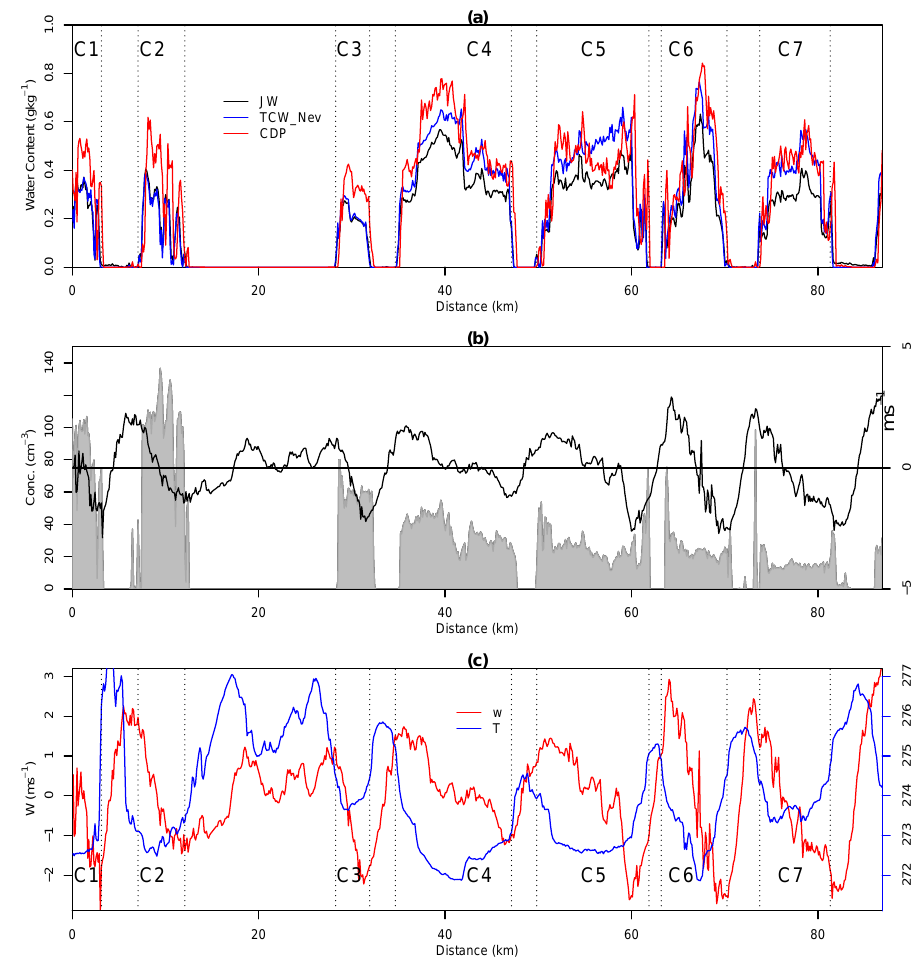
Fig. 4. (a) The LWC measured by the Johnson-Williams probe, the Nevzorov total cloud water, and as derived from the CDP, (b) , concentra- tion with CDP in grey shade and vertical velocity in black curve (b) , and vertical velocity in red and temperature in blue (c) in Run 1.